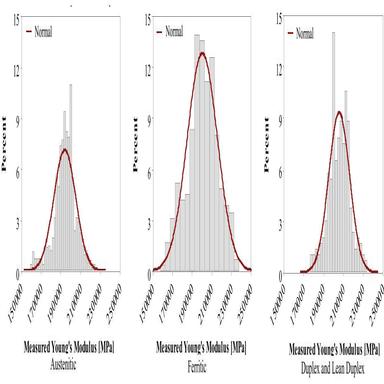
Histograms of Young's modulus E for different stainless steel types.